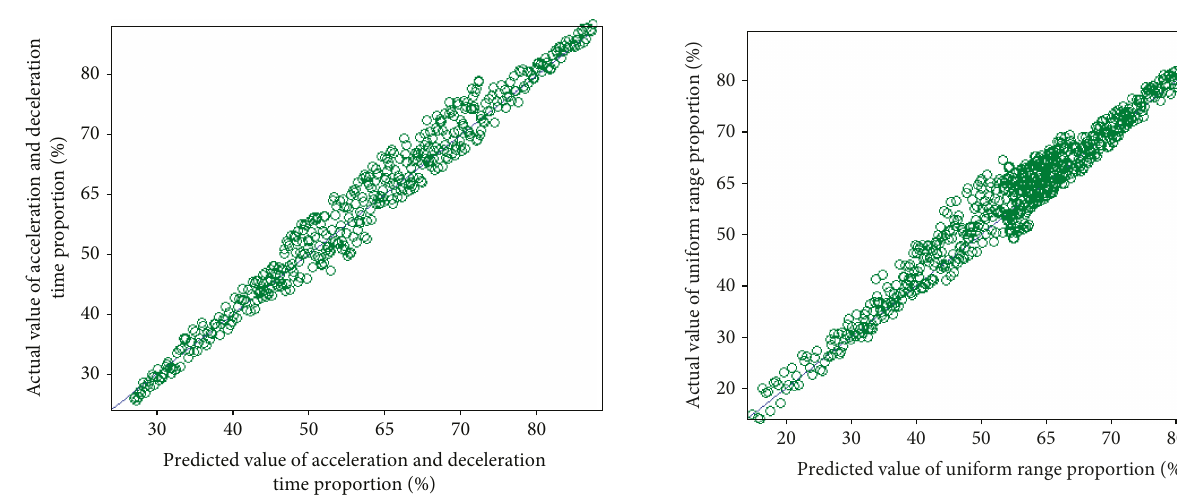
Figure 15: Scatter diagram of predicted values and actual values (braking time proportion).